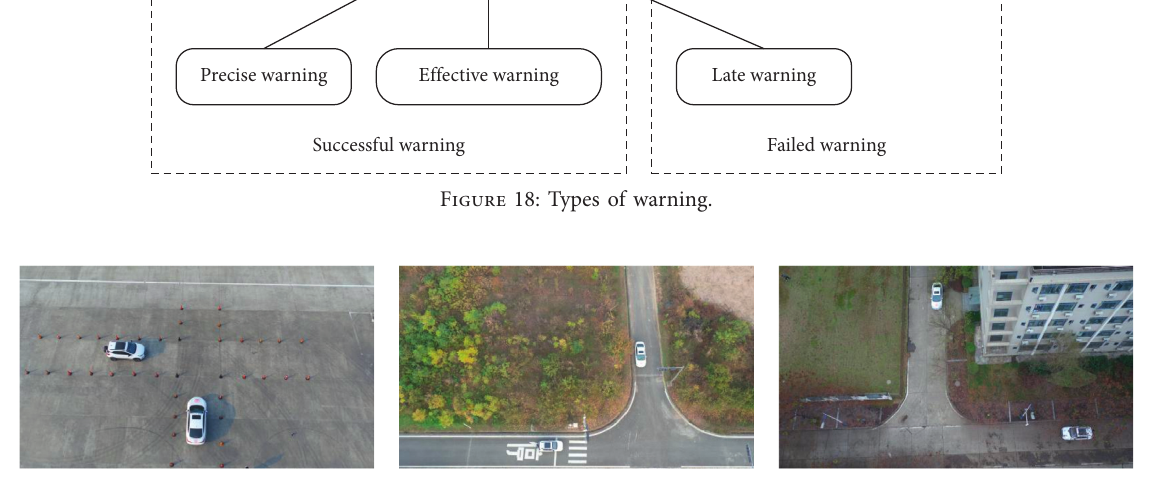
Figure 19: Intersection collision warning (ICW) function test scenarios. (a) LOS intersection scenario (scenario 1). (b) Rural intersection (scenario 2). (c) Urban intersection (scenario